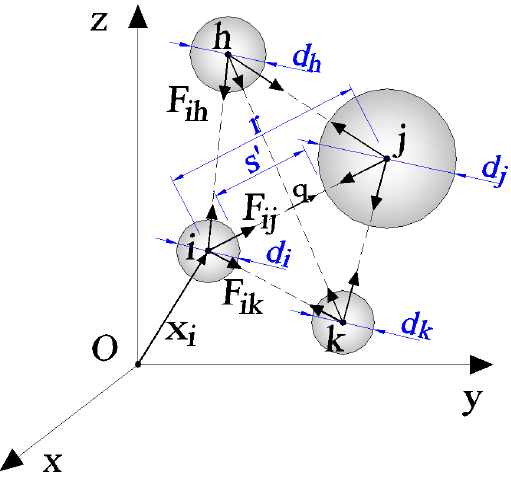
Figure 1: Scheme of pair-wise interparticle